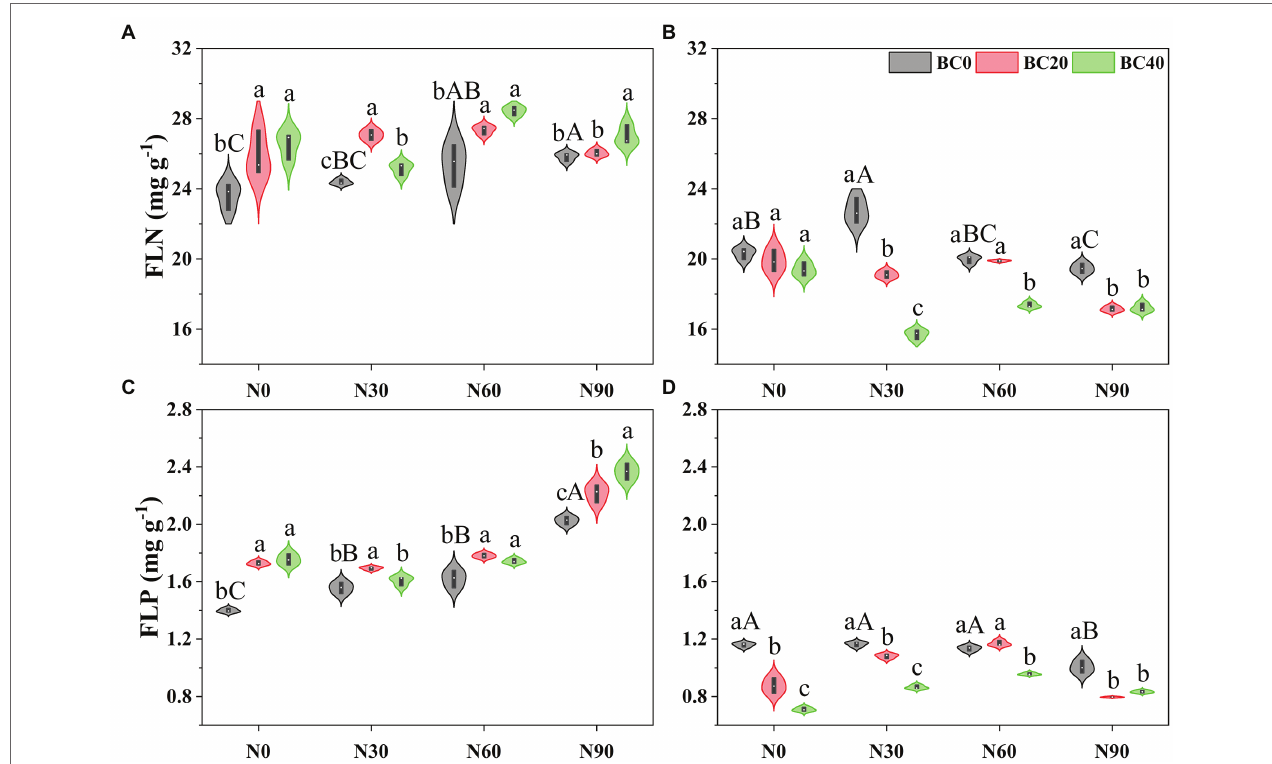
FIGURE 1 | Fresh leaf nitrogen (FLN) and phosphorus (FLP) concentrations in young (A,C) and mature (B,D) bamboo under different N addition and biochar amendment treatments. N0, N30, N60, and N90 refers to 0, 30, 60, and 90 kg N ha − 1 yr − 1 , respectively, and BC0, BC20, and BC40 refers to 0, 20, and 40 t biochar ha − 1 . Capital letters indicate a significant difference between different N addition treatments in the BC0 treatment at the 0.05 level. Lowercase letters indicate a significant difference between different biochar treatments in the same N addition treatment at the 0.05